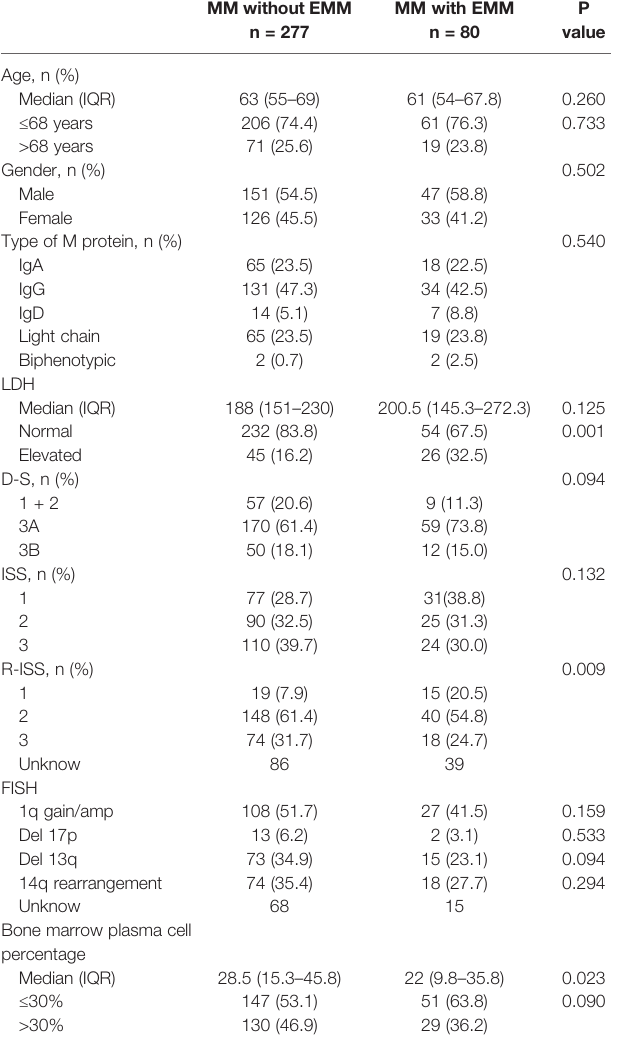
TABLE 1 | Clinical Characteristics of EMM and no EM patients at diagnosis (N =